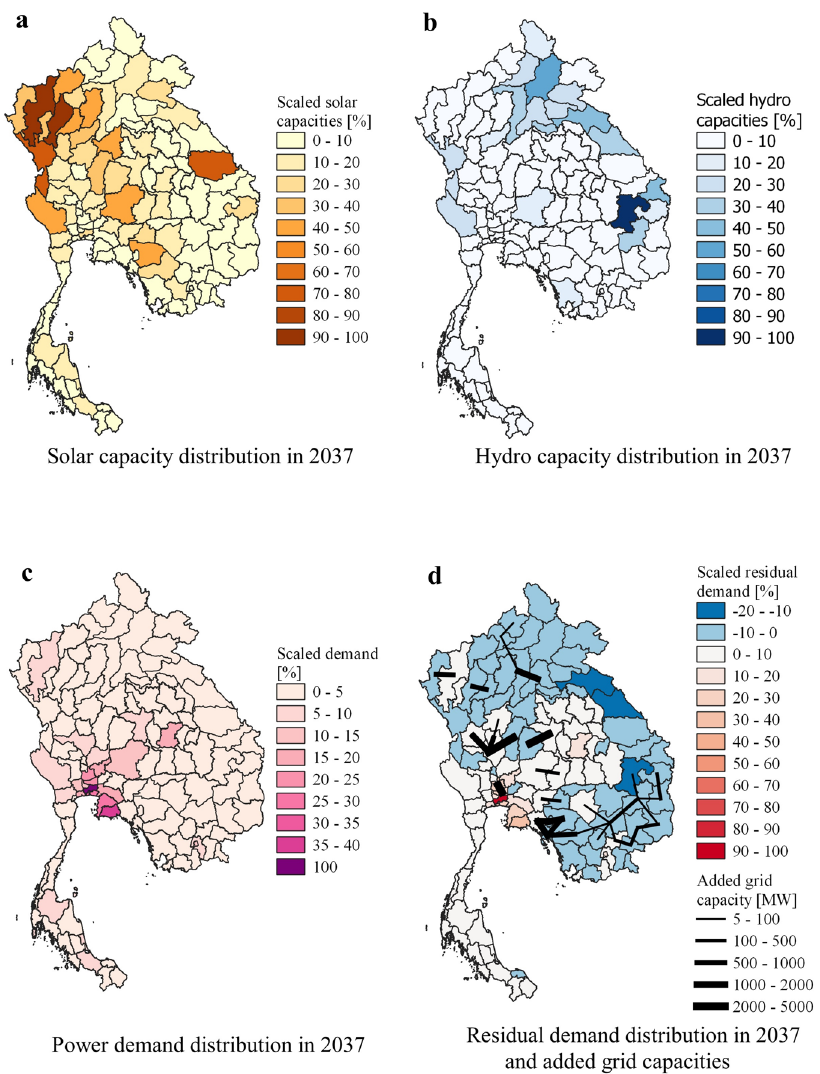
Fig. 3 Spatial analysis. Regional distribution of the solar capacities ( a ), hydro capacities ( b ), power demand ( c ), and residual energy demand ( d ) in 2037. The maps are scaled to the respective maximum regional quantity. The residual energy demand is calculated by subtracting the annual energy production of solar PV, onshore wind, and hydro from the annual power demand and is indicative of the regional discrepancies between supply and demand. The transmission capacities that are added between 2020 and 2037 are also plotted on sub fi gure in ( d